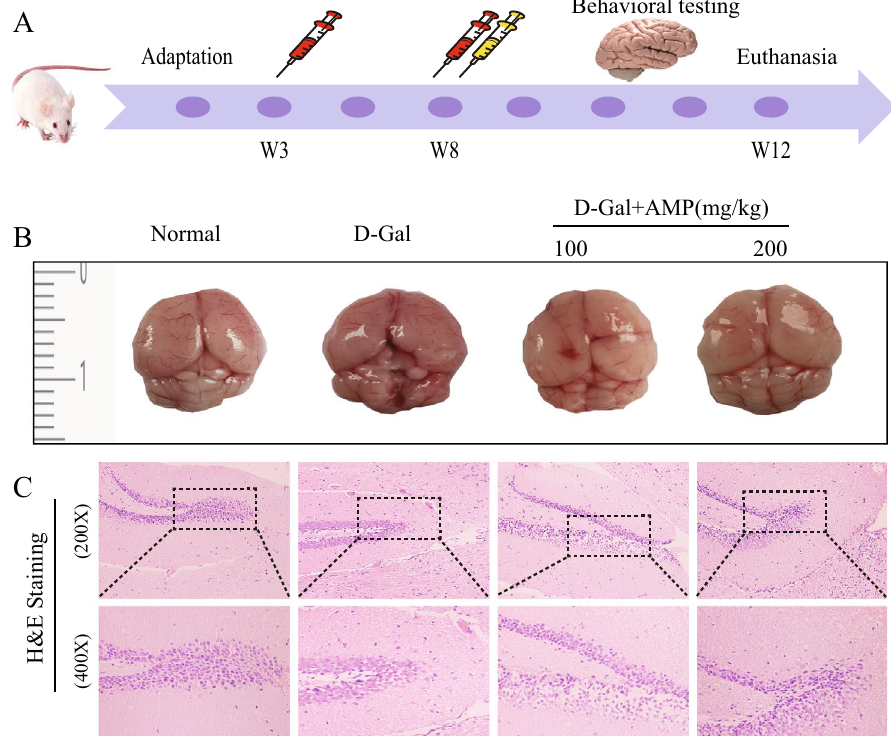
Figure 2. AMP improves the general condition of mice. ( A ) Experimental design of the D-Gal-induced liver fibrosis model in mice. ( B , C ) AMP improved the appearance of the whole brain of aging mice and H&E staining showed the pathological damage of the hippocampus. Images were obtained using Canon EOS 1600D\u002F 200D II (http:// www. canon. com. cn/), and processed with Adobe Photoshop CC 2018 (https:// www. adobe. com/ produ cts/ photo shop. html). The drawing was created using Adobe Illustrator CS 11.0 (https:// www. adobe. com/ cn/ produ cts/ illus trator. html). The stained sections were collected by light- microscope Leica DM750